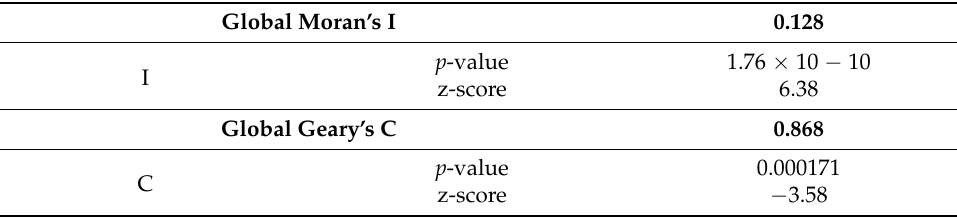
Table 3. Global Moran’s I and Global Geary’s C spatial dependency test.